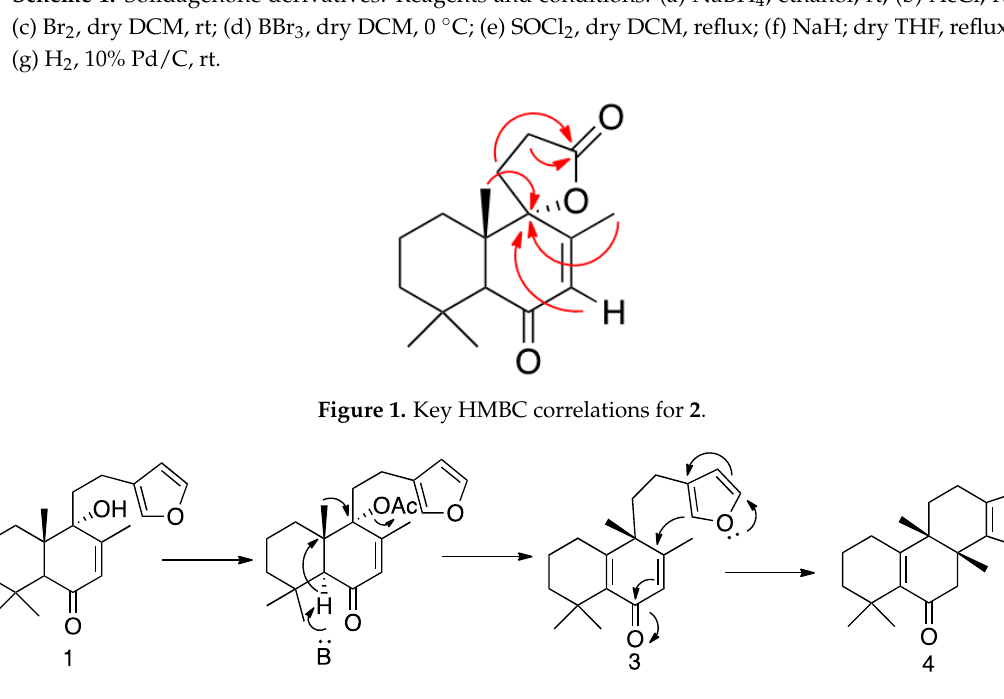
Scheme 2. Plausible formation of compounds 3 and 4 .